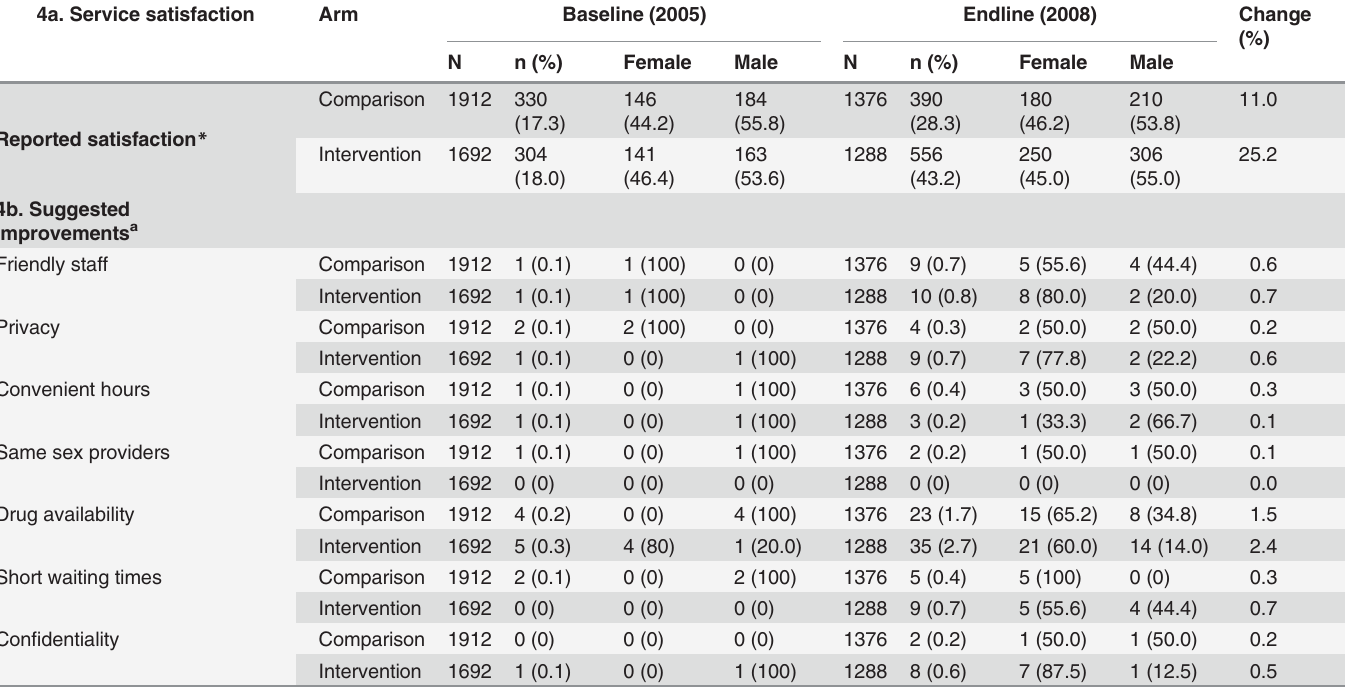
Table 4. Frequency of reported satisfaction with services and suggested improvements, comparing intervention to comparison responses at baseline and endline. 4a. Service